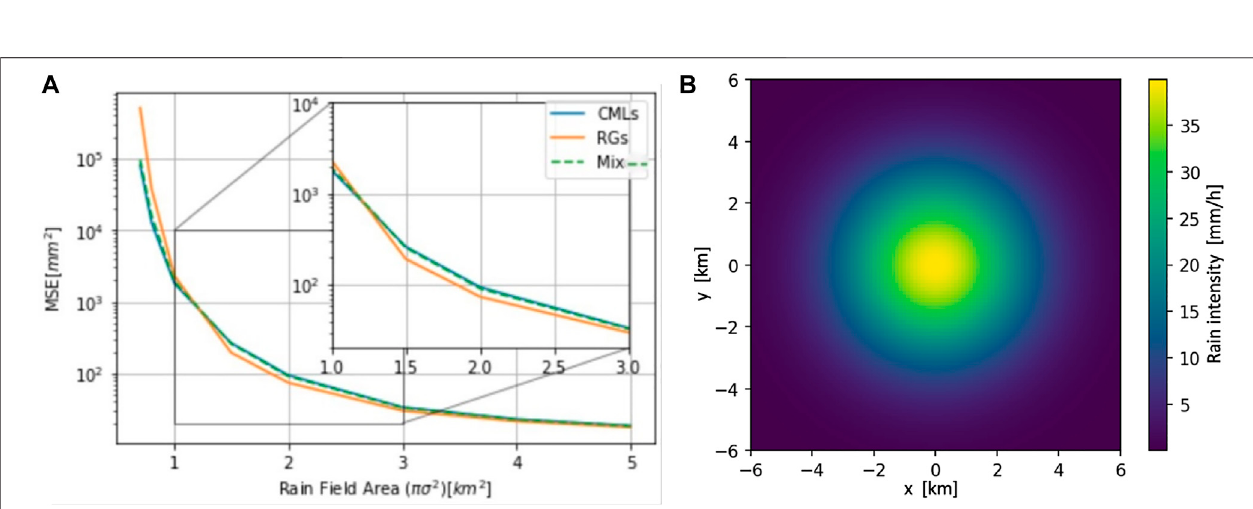
FIGURE 5 | As in Figure 3 for the three sensor networks of Figure 4 , where the GRC is located at (0, 0) with a peak rain intensity of 20 [mmh − 1 ].